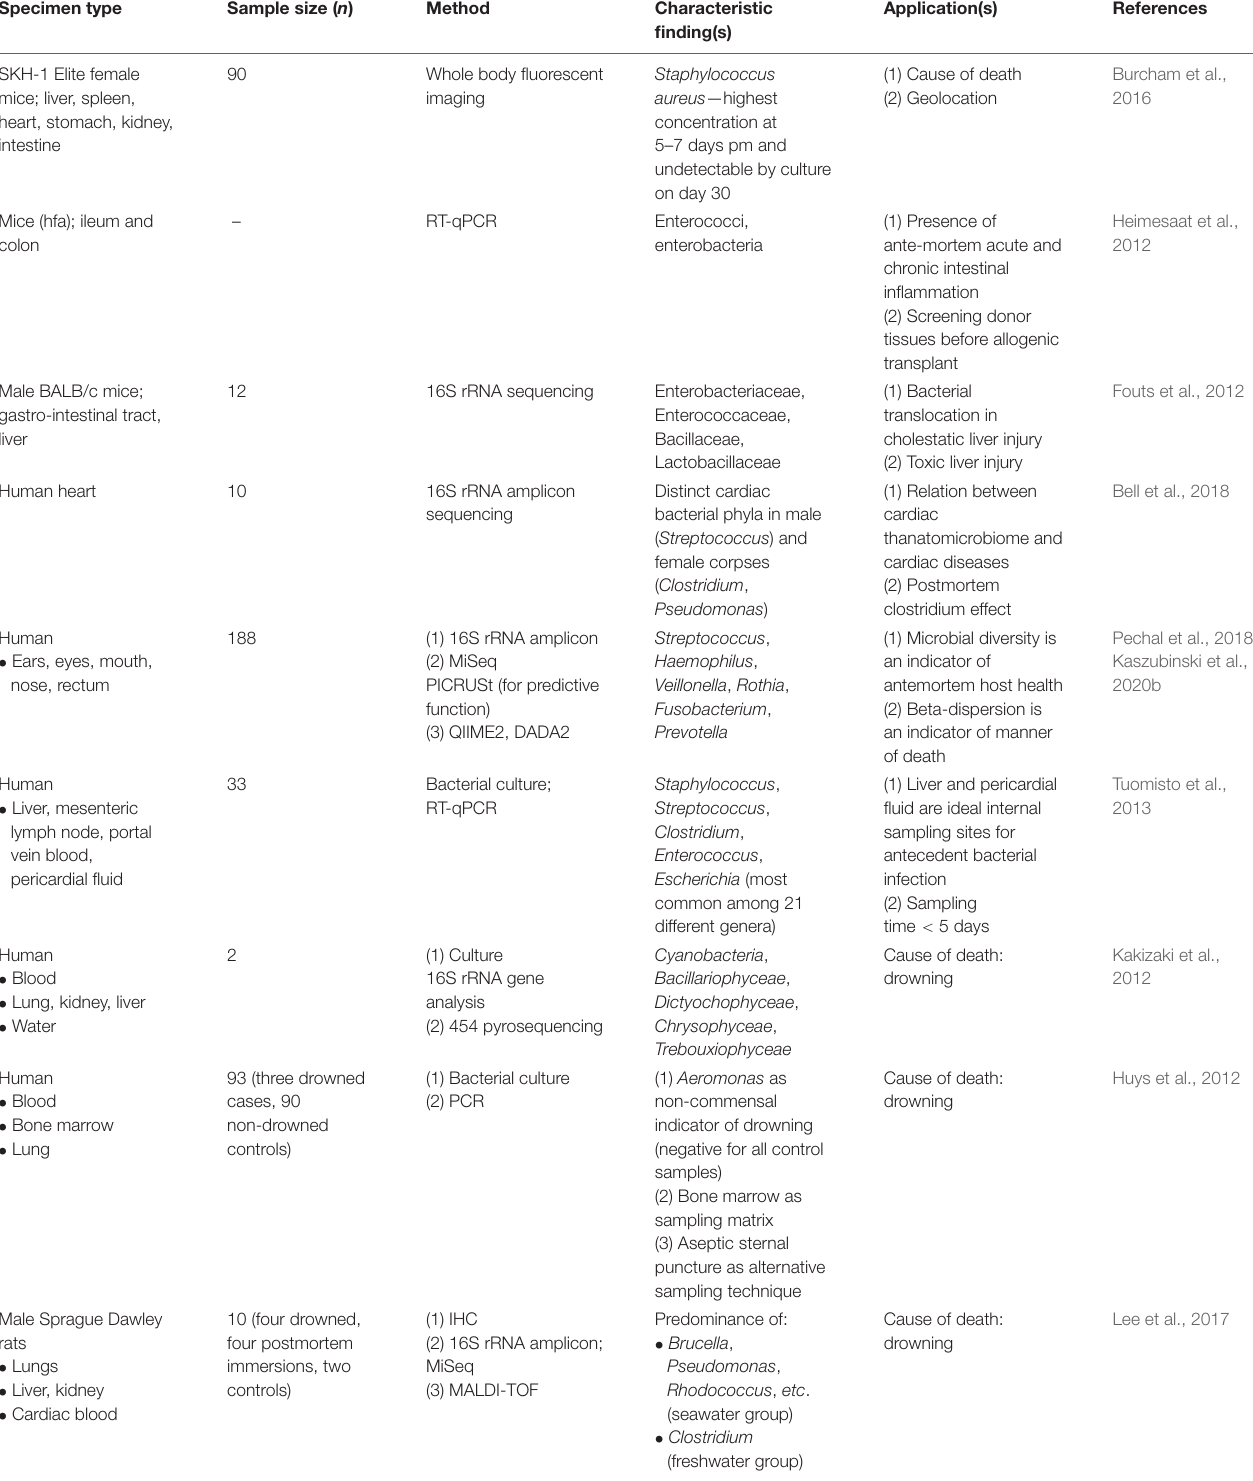
TABLE 1 | Potential applications of thanatomicrobiome in diagnosing cause of death. Specimen